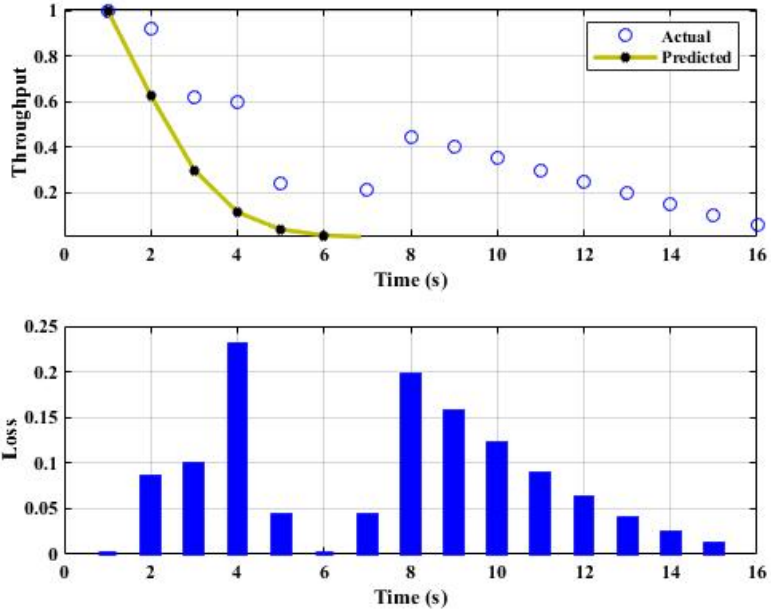
Figure 4. The predicted output at a transmission rate of 6 packets/s.